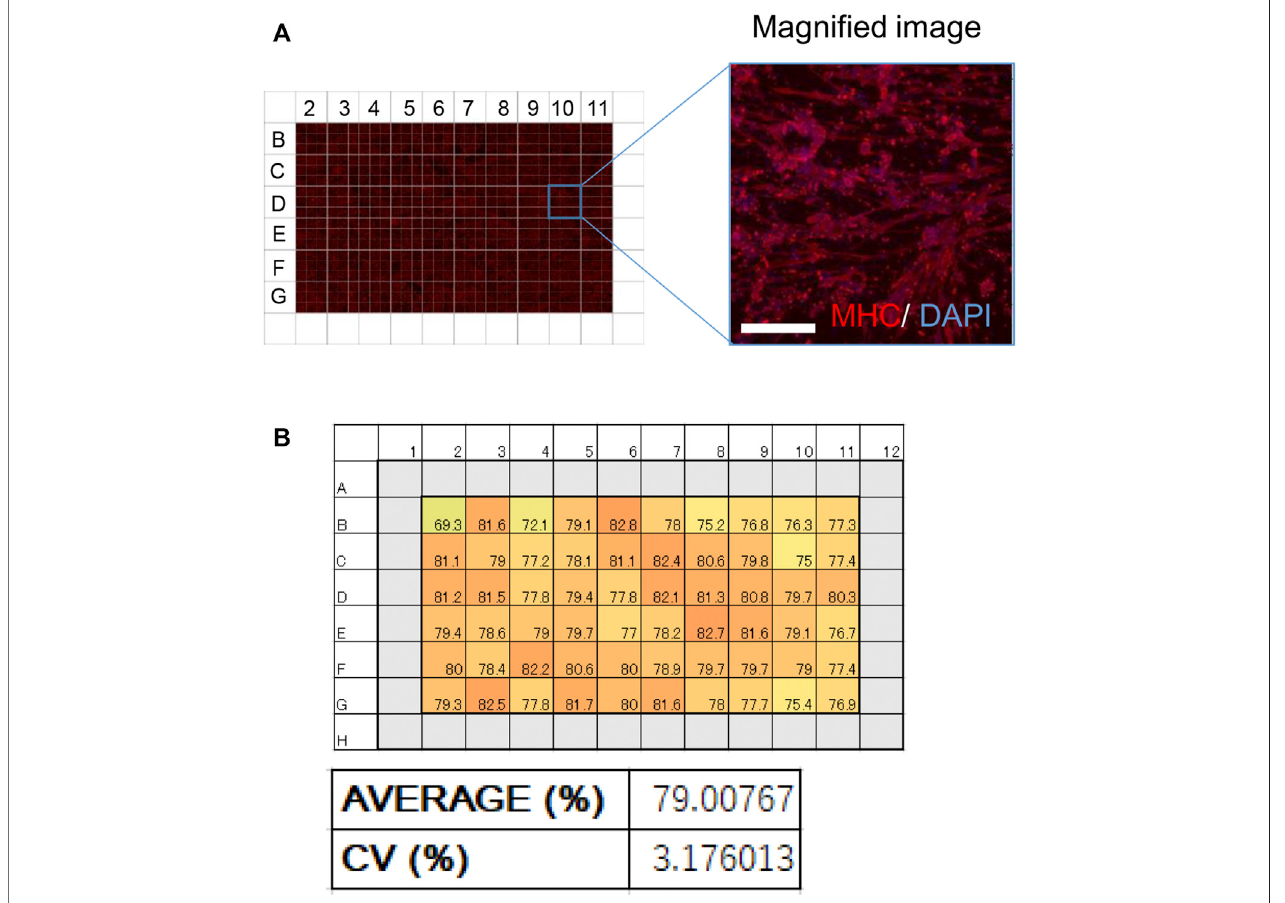
FIGURE4| Effectiveandhomogeneousdifferentiationsystemina96-wellplate. (A) AnimageofMHC-stainedmyotubes(red)ina96-wellplate.Amagni fi edimage isalsoshown.Scalebar,100 μ m. (B) Schematicofthe96-wellplateusedinthescreening.(Upper)NumbersineverywellindicatetheratioofMHC-positivenucleitototal nuclei (%). (Lower) A bar graph of the ratio of MHC-positive nuclei in the 96-well plate. The average ratio of MHC-positive nuclei and the coef fi cient of variation (CV) are shown.